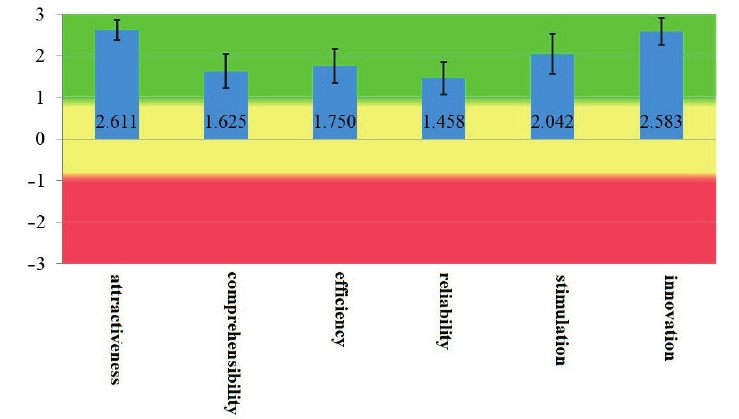
Figure 1. Quiver Application evaluation results using user experience questionnaire method (source: created by the